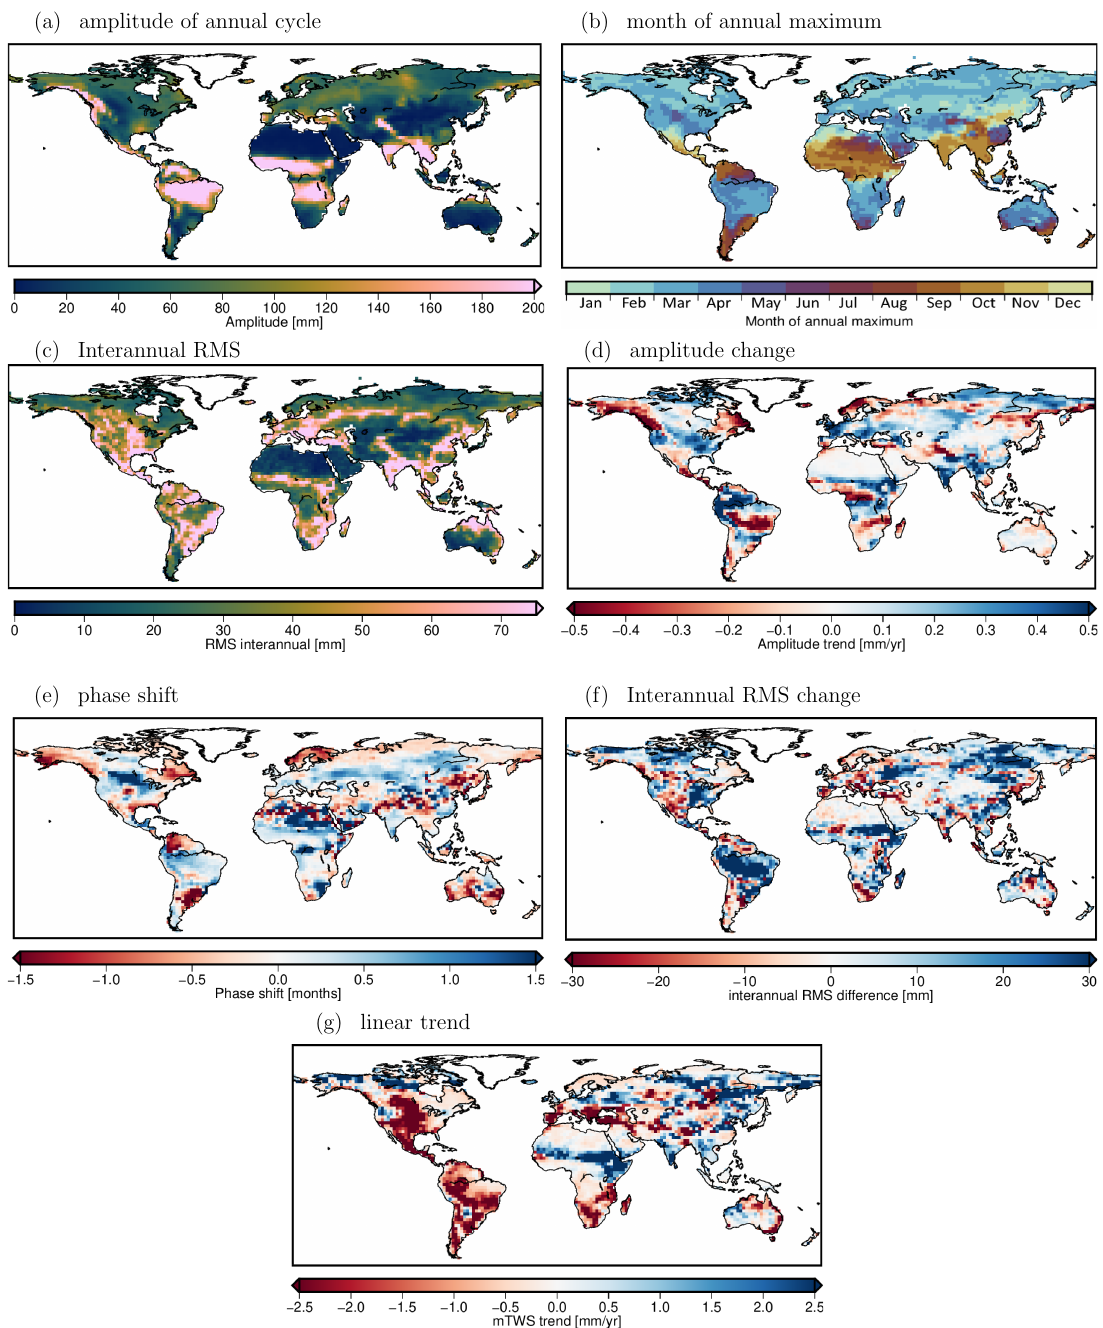
Figure 13. mTWS variability of selected model run GFDL-CM4 r1i1p1f1. ( a ) Amplitude of annual cycle, ( b ) month of the maximum of the annual cycle, ( c ) interannual RMS; ( a – c ) for the time